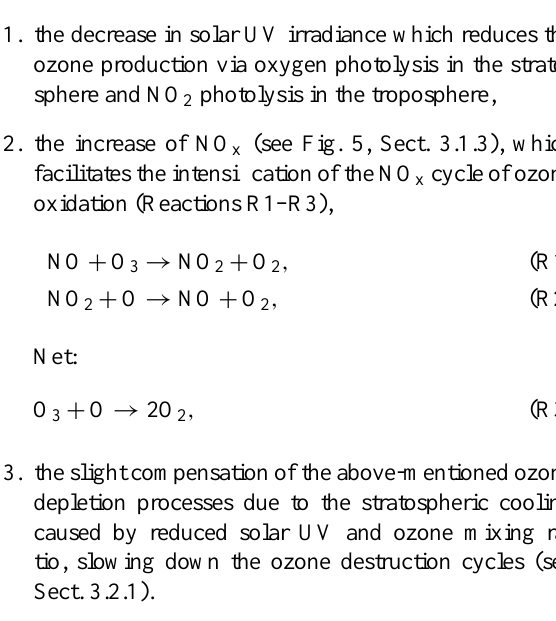
Fig. 2. Relative differences of yearly mean ozone of the DM-ALL, DM-TD, DM-VOLC and DM-EPP experiments with relation to the DM-CTRL1780 forcing run. Hatched areas are significantly differ- ent on a Student’s t test with α = 5%. The yellow line illustrates the height of the WMO